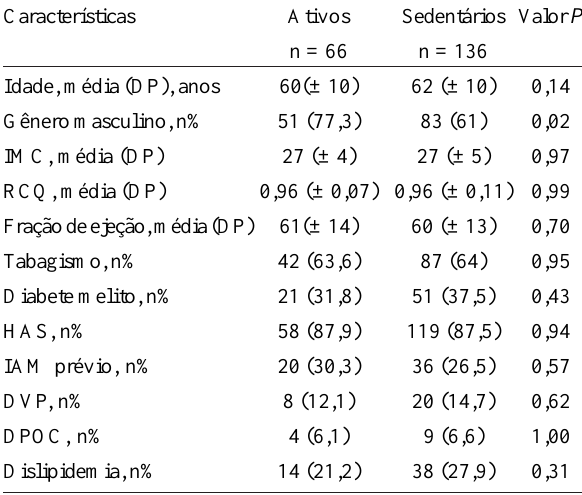
periférica; DPOC= doença pulmonar obstrutiva crônica.